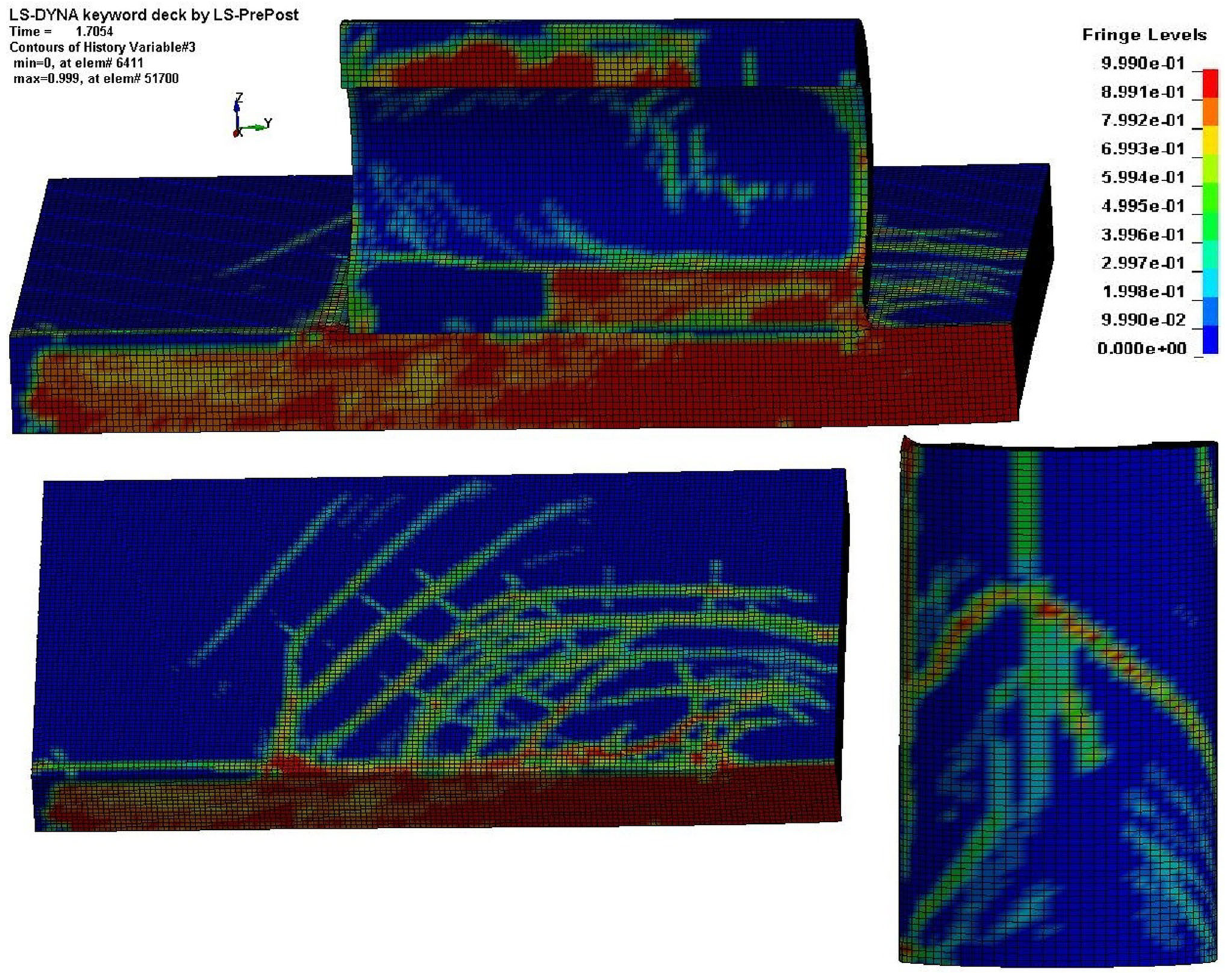
Fig. 17 Contours of ductile damage at t = 1.7054